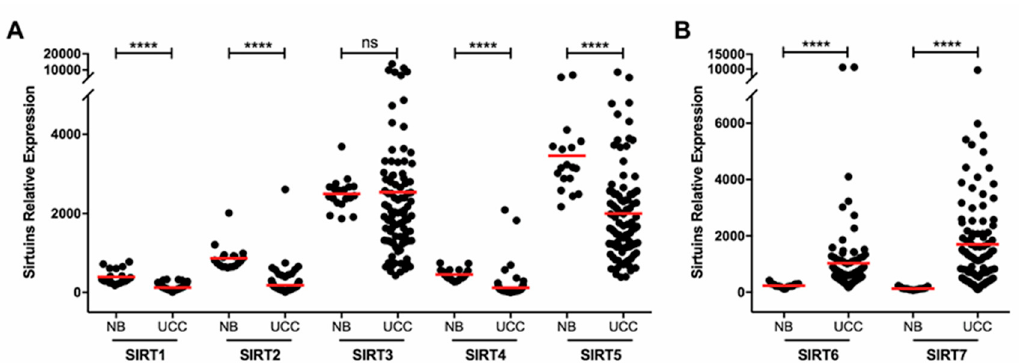
Figure 1. Sirtuin family transcript levels characterization in bladder urothelial carcinoma. Characterization of SIRT1, SIRT2, SIRT3, SIRT4 and SIRT5 ( A ), and SIRT6 and SIRT7 ( B ) in the bladder cancer and normal mucosae cohorts, by quantitative RT-PCR. **** p < 0.0001, ns—nonsignificant. UCC—urothelial cell carcinoma, NB—normal bladder mucosae.